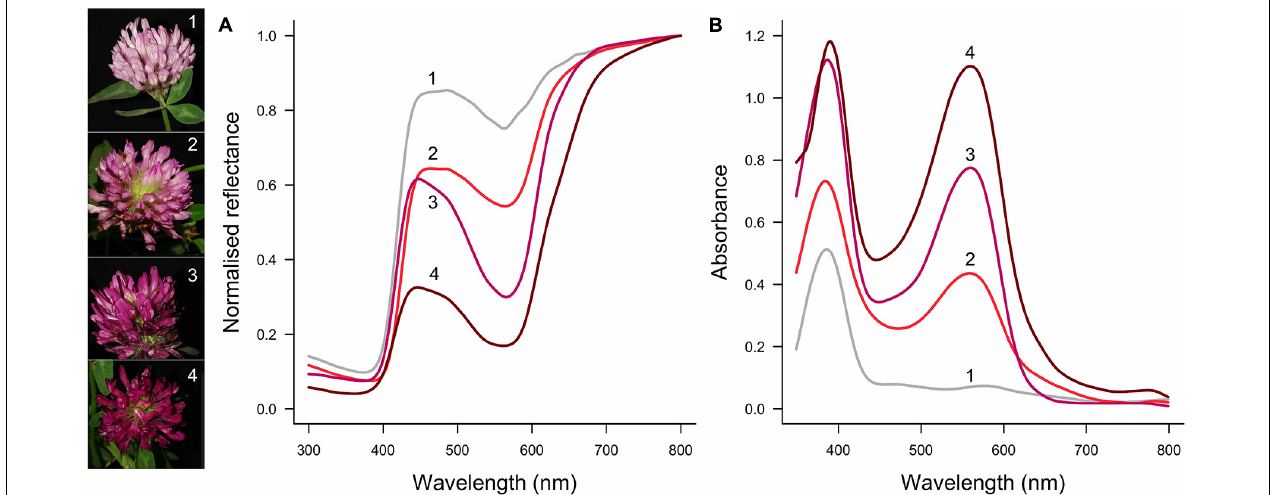
FIGURE 1 | Example of intraspecific flower color variation in Trifolium pratense . Flower color ranges from light pink (1) via pink (2, 3) to dark red (4). From light to dark, modulation of the reflectance spectra increases, particularly between 500 and 600 nm (A) , which is due to an increase in the amount of pigment with peak absorption at ∼ 550 nm (B) . Flowers of this species also have a UV-absorbing pigment, the amount of which varies less than the pigment that absorbs in the green wavelength range. The numbered spectra correspond to the left pictures (photo credit: Alina Höwener).